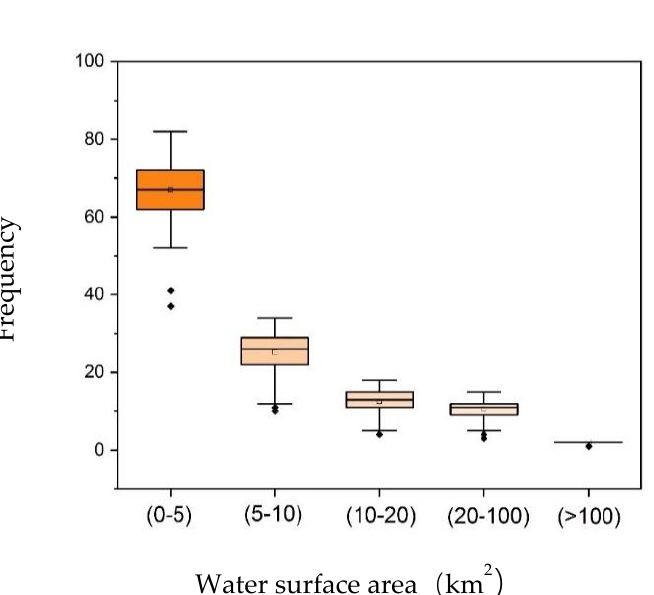
Figure 5. Frequency of 209 water bodies (>1 km 2 ) in five size classes in the Nenjiang River Basin, Northeast China. Each boxplot illustrates the median and inter-quartile range and the whiskers indicate minimum and maximum values.